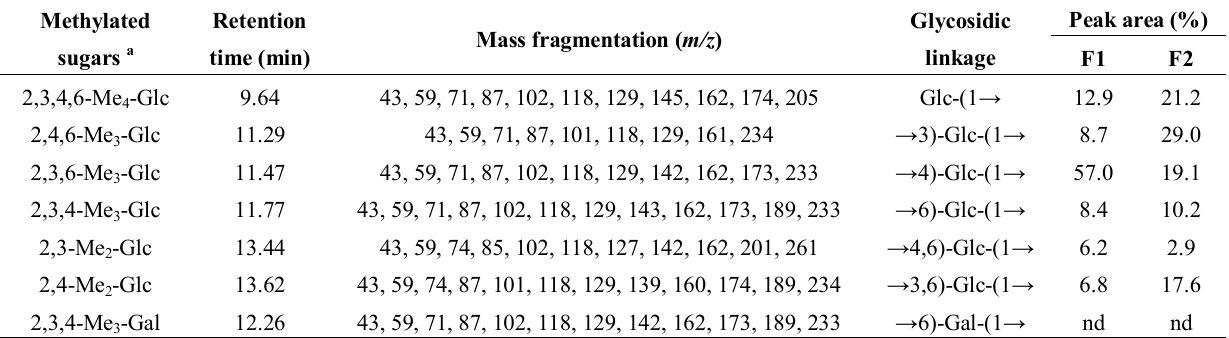
Table 2. Glycosidic linkage analysis of the constituent sugars of the F1 and F2 fractions originated from H. marmoreus